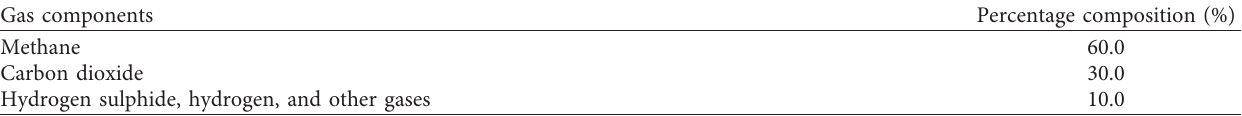
Table 4: Optimum biogas composition for the biogas